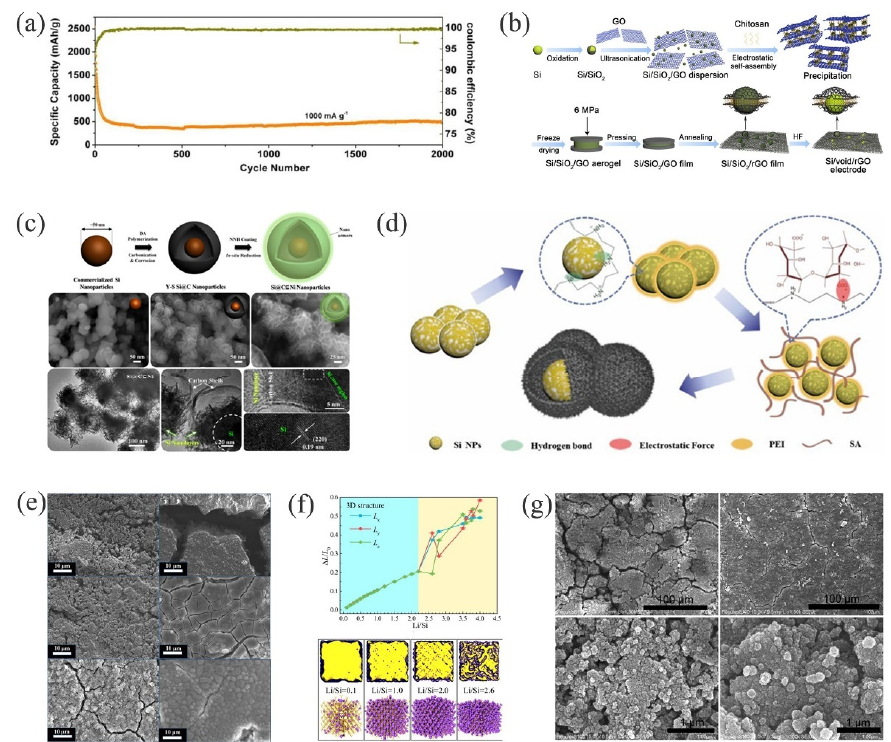
Figure 6. ( a ) Long-term cycling performance of the Si@HC − 1 [159]. Reprinted with permission